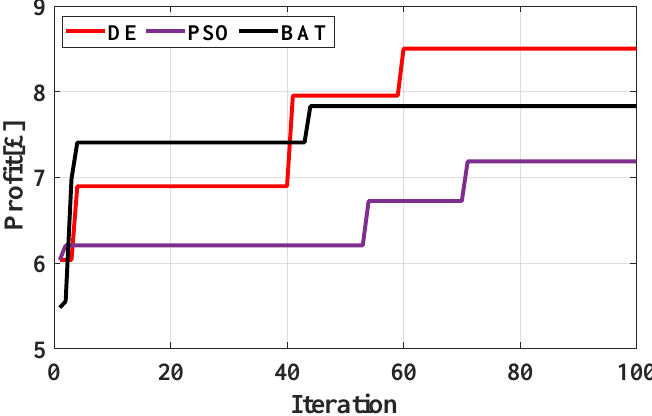
Figure 11. Electrical/thermalMCPprofileatatimeintervalunder24-hoperationbydifferentoptimizationmethods.